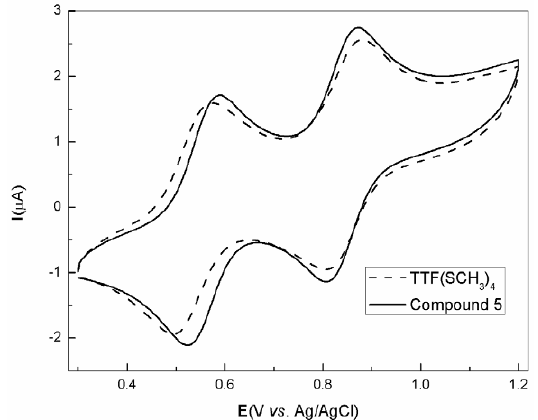
Figure 2. Cyclic voltammetry of compound 5 and parent TTF(SMe